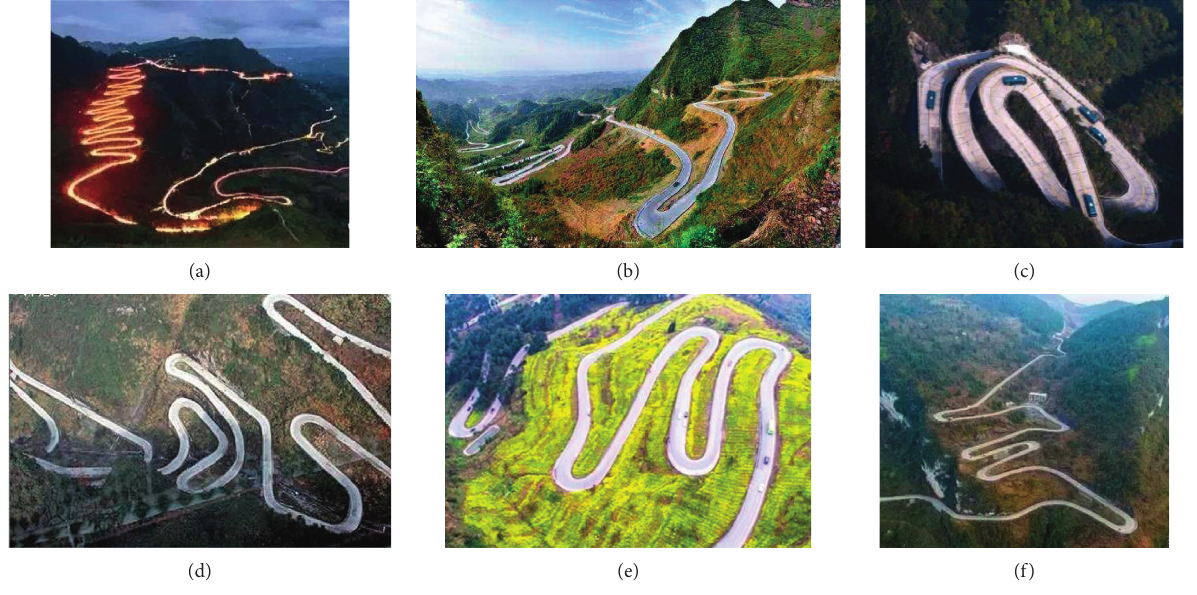
Figure 1: Winding mountain roads with dense turns in